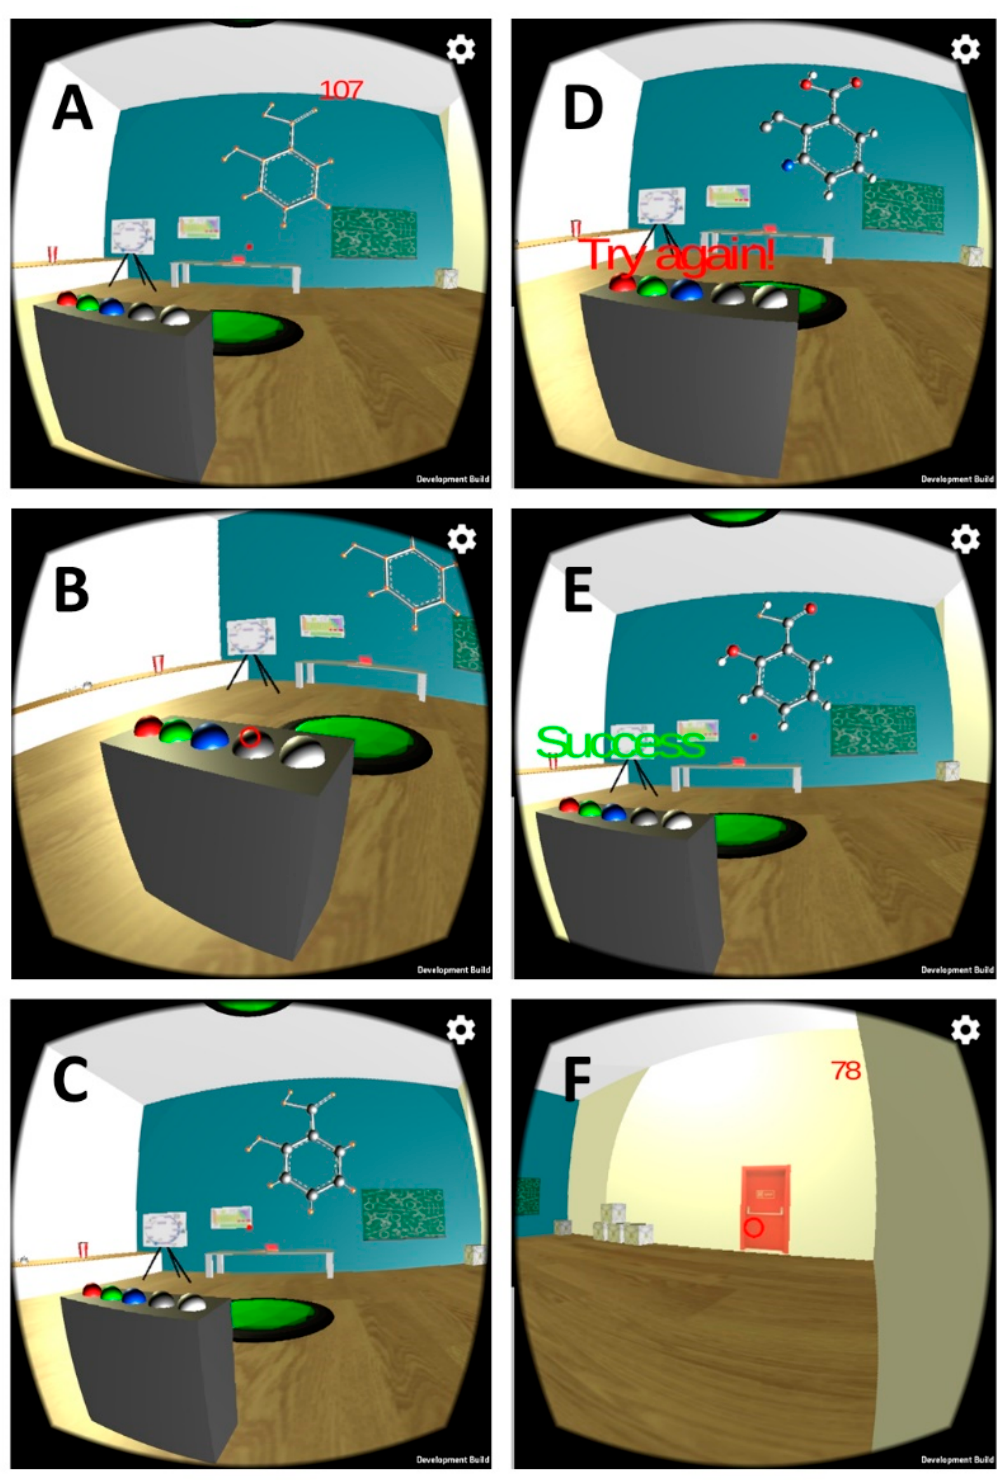
Figure 4. Screenshots of the real-life MedChemVR game in the “Take a Quiz” mode. The screenshots present different activities aiming to evaluate the user’s knowledge. ( A ) Main scaffolding with no atoms, ( B ) installing atoms in the scaffolding, ( C ) positioning the atoms, ( D ) “Try Again” message appears when the atoms are incorrectly positioned, ( E ) “Success” message appears when the atoms are correctly positioned (2D) complete structure by the student, ( F ) Exiting the VR room and the testing part of the application back to the main menu.